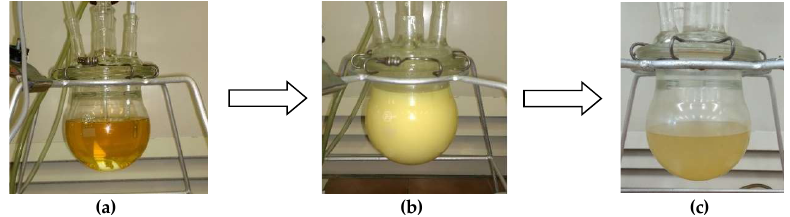
Figure 3. Visual presentation of appearance changes during synthesis ( a ) EPO, ( b ) EPEO, and ( c ) EPB.